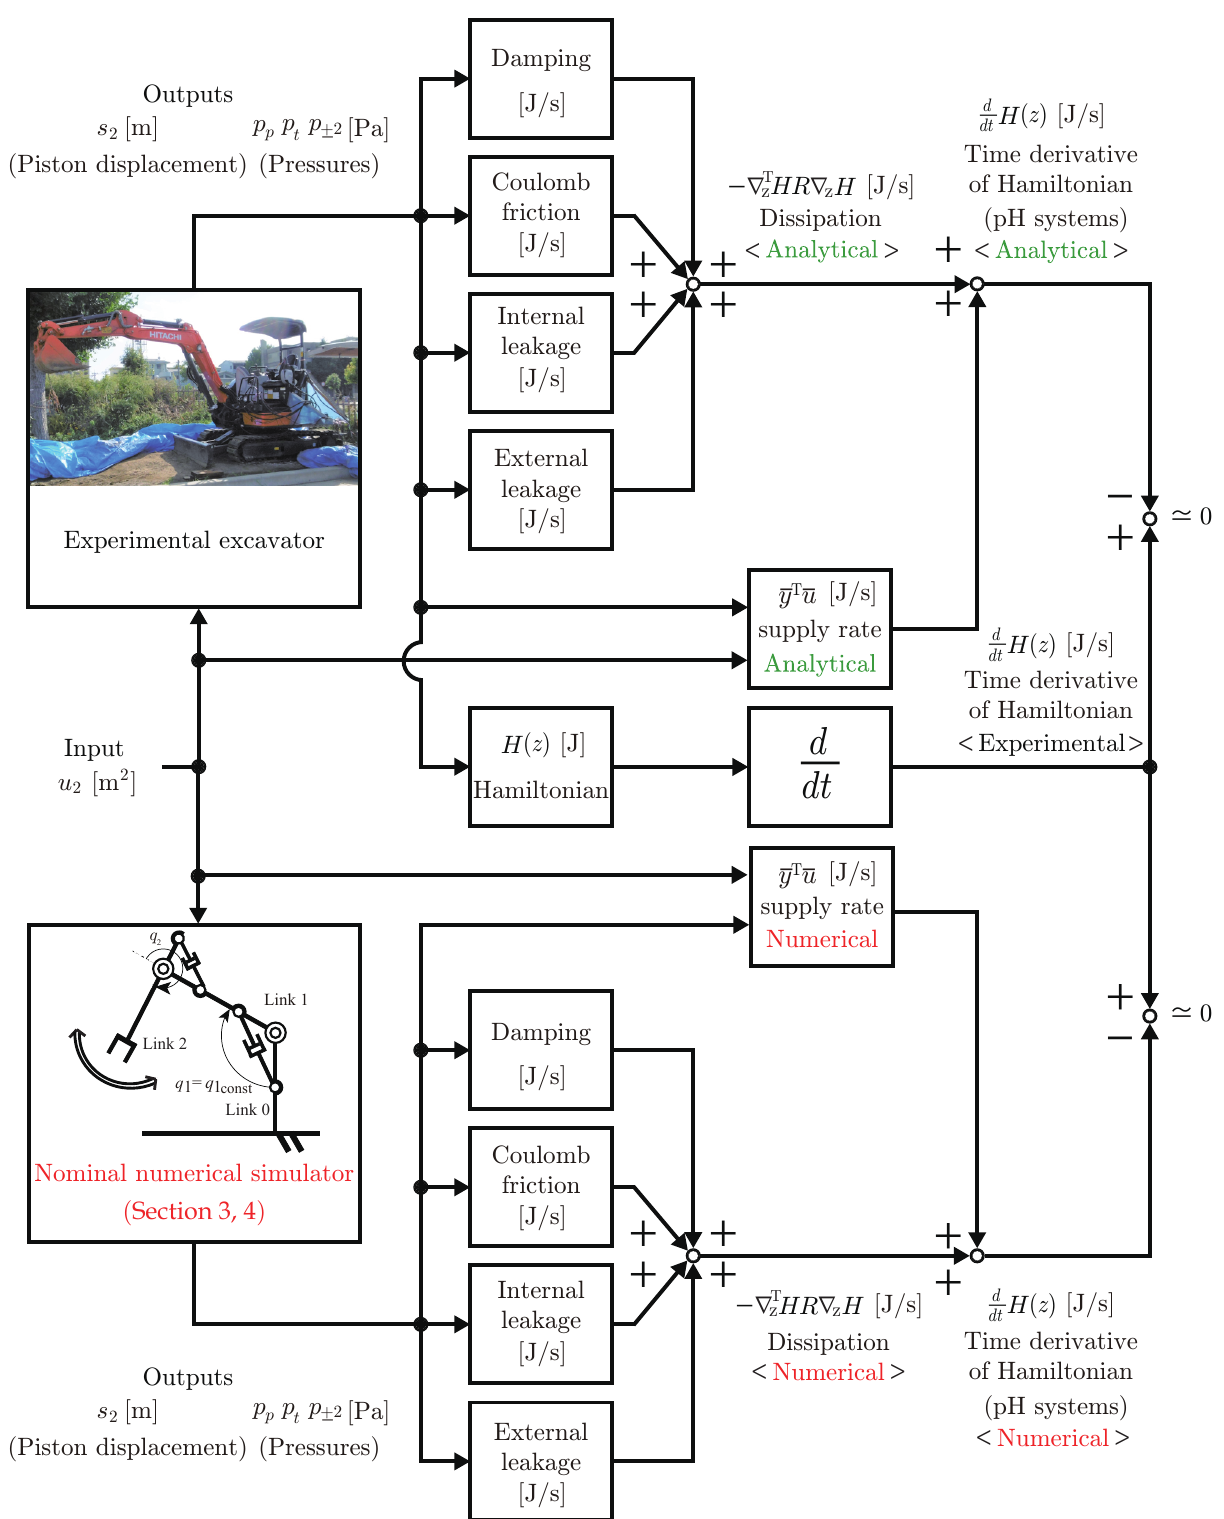
Figure 9. Comparisons of experimental vs. numerical vs. analytical energy